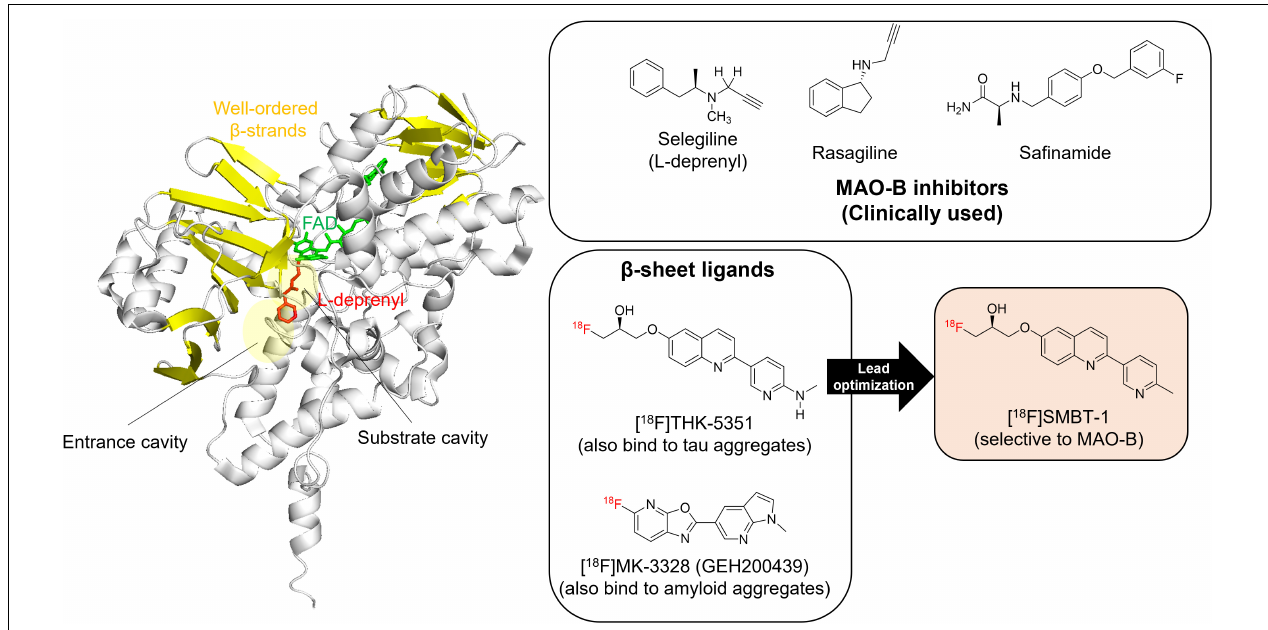
FIGURE 3 | Crystal structure of MAO-B complex with L-deprenyl. Molecular image of 2BYB (De Colibus et al., 2005) created using PyMOL software. Yellow: β -strands. Red: L-derepnyl. Chemical structures of clinically used MAO-B inhibitors (selegiline, rasagiline, and safinamide), β -sheets ligands that binds to MAO-B ([ 18 F]THK-5351 and [ 18 F]MK-3328), and a novel MAO-B PET tracer, [ 18 F]SMBT-1. Although the detailed binding site of β -sheets ligands such as [ 18 F]THK-5351 and [ 18 F]MK-3328 remains unknown, the evidence suggest that β -sheet ligands are potential MAO-B binders. In fact, lead optimization of one of β -sheet ligands, [ 18 F]THK-5351, generated a novel MAO-B PET tracer, [ 18